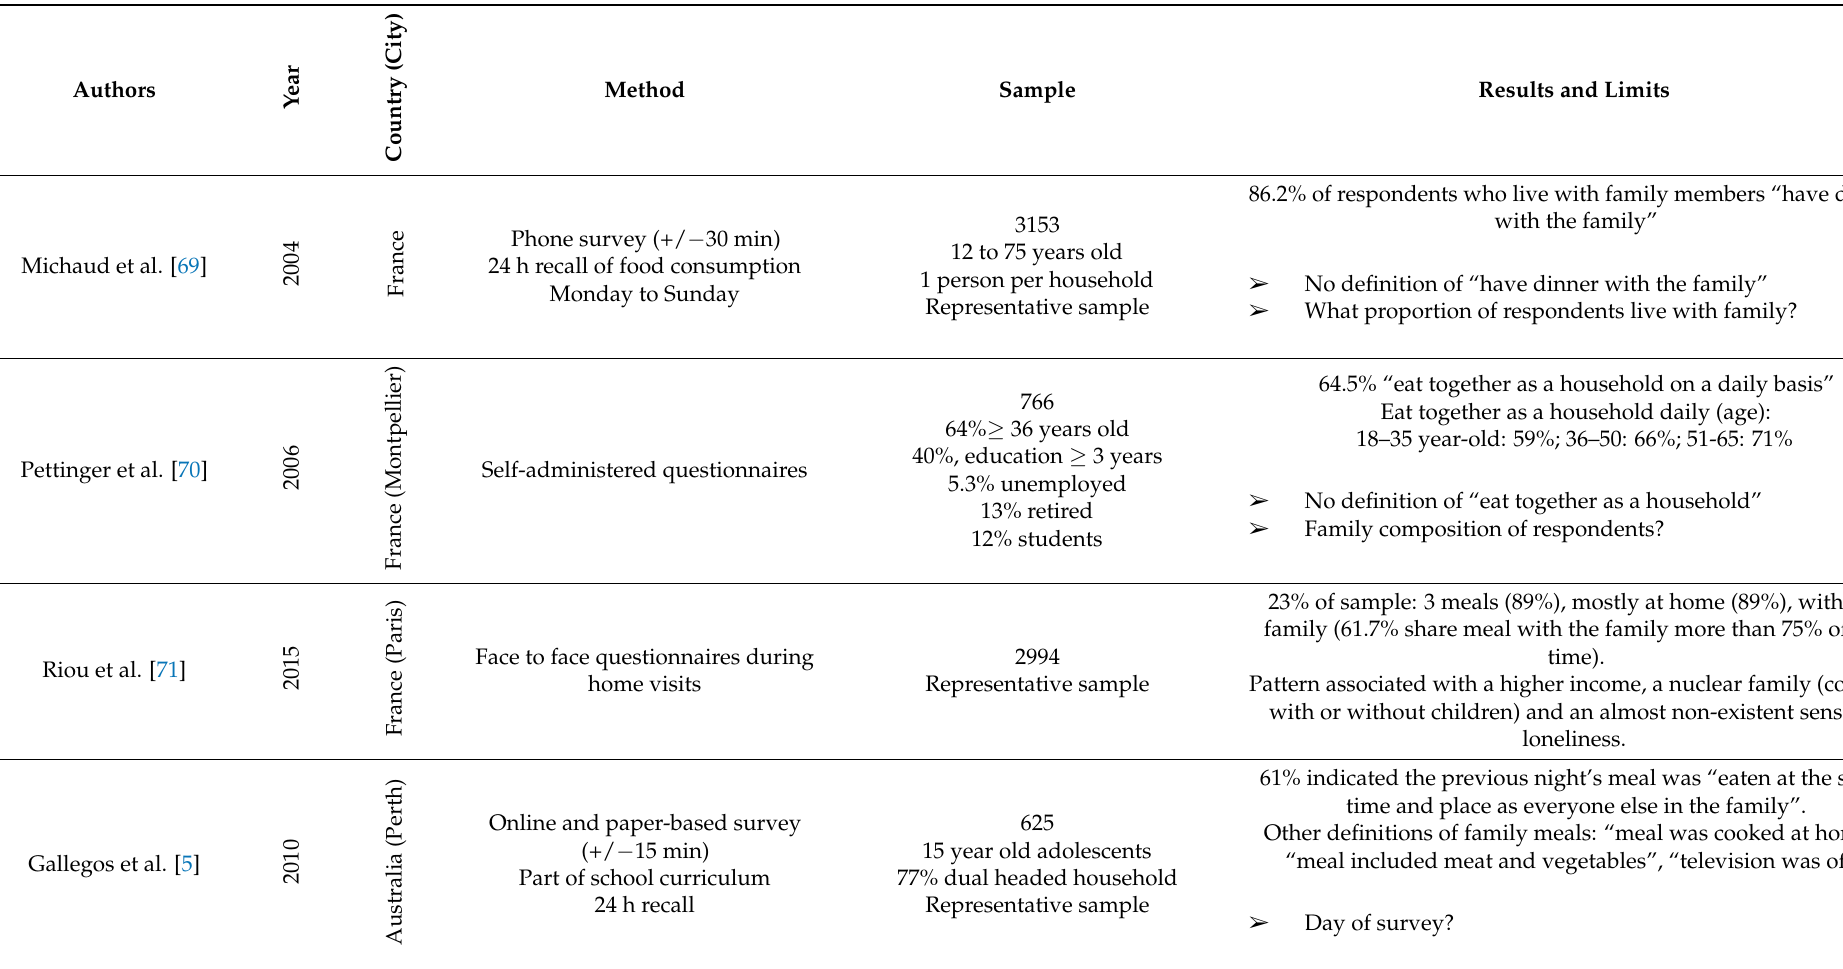
Table 3. Prevalence of family meals: selection of